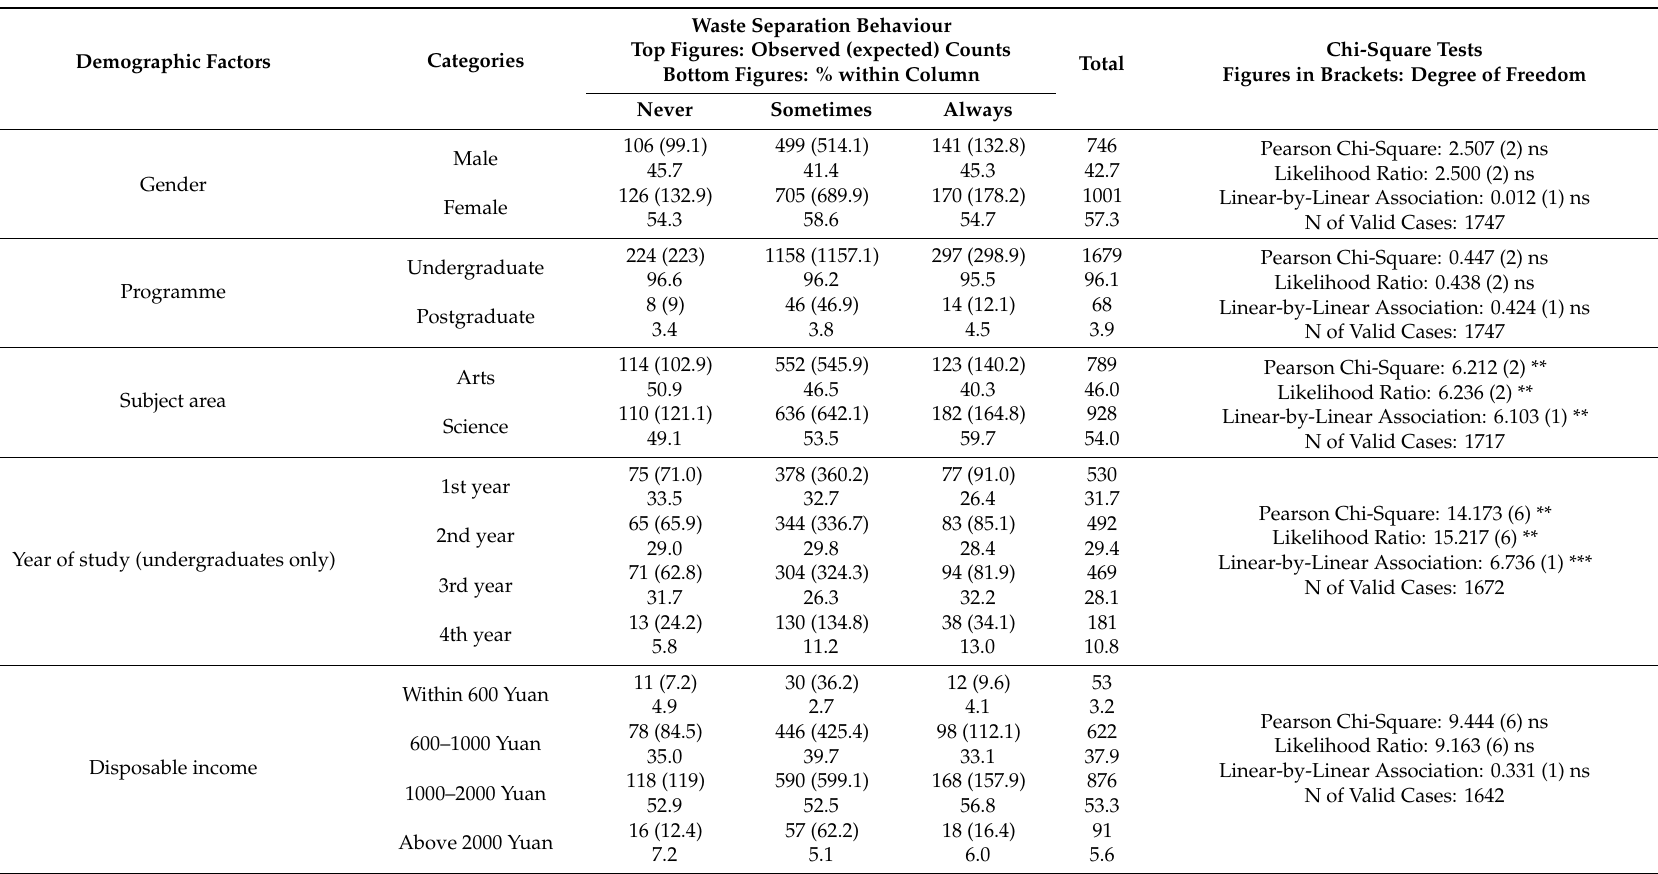
Table 3. Demographic information and waste separation